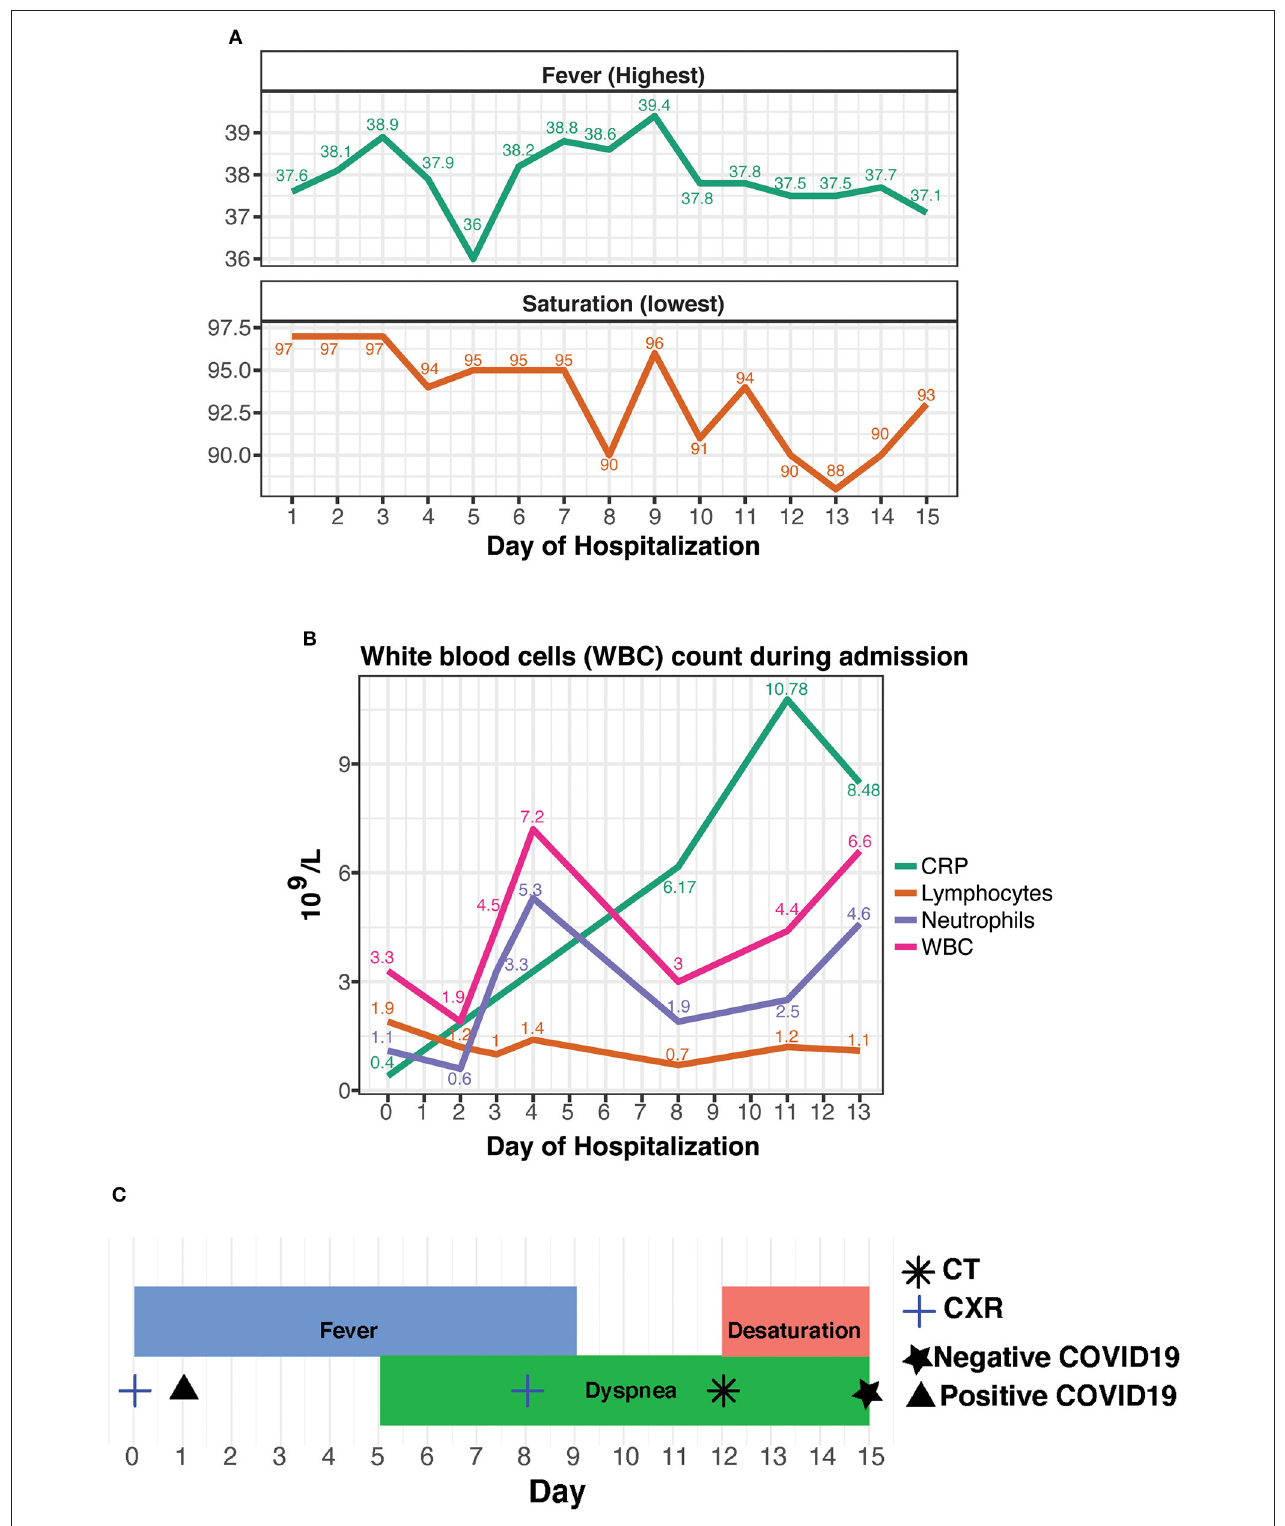
FIGURE 1 | (A) Daily lowest non-invasive oximetry values in room air (as %) and daily highest fever (in ◦ Celsius), as measured through hospitalization. (B) Leukocyte count and CRP results, as analyzed during admission. (C) A timeline of the hospitalization with concurrent events and tests.